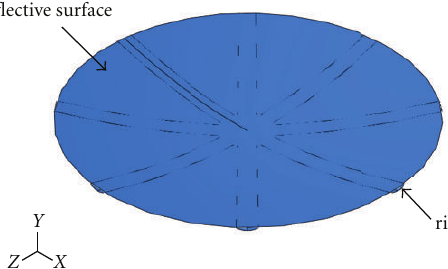
Figure 4: Reflective surface with tape spring, case